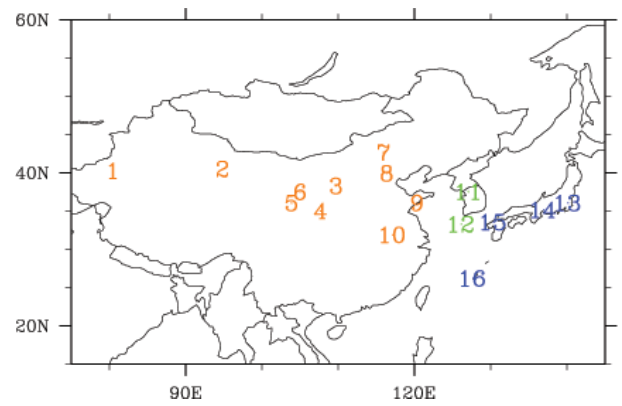
Fig. 6. Location of Asian stations to derive the dust surface con- centration from visibility in spring of 2000 and 2001. Stations are divided into three groups according to the country: China (orange), South Korea (green) and Japan (blue). Name, latitude and longitude of each station are listed in Table 5.